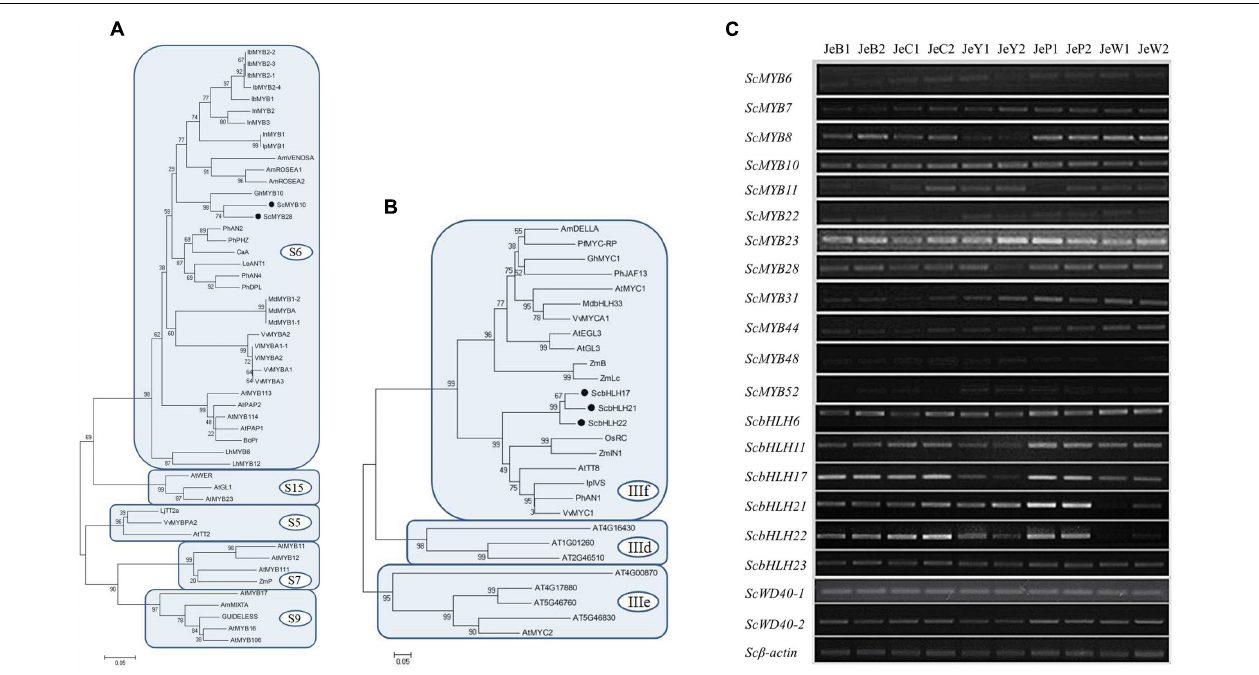
FIGURE 6 | Hierarchical clustering analysis of the expression patterns of anthocyanin genes in S. cruentus. (A) Phylogenetic relationship among ScMYBs genes and other plant MYB homologous genes. (B) Phylogenetic relationship among ScbHLHs genes and other plant bHLH homologous genes. (C) Expression patterns of all S. cruentus regulatory genes among five